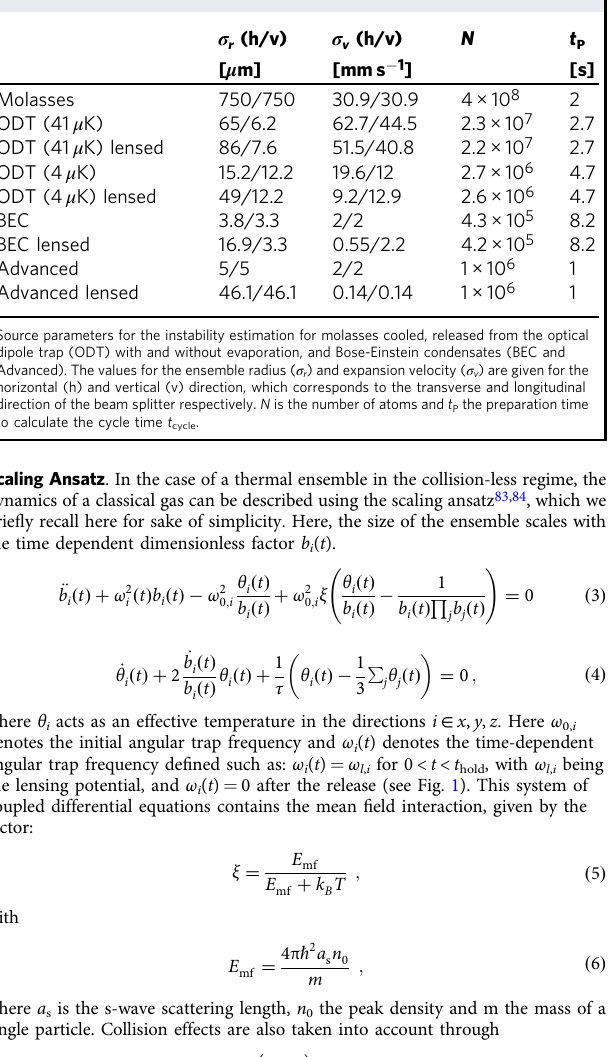
Table 1 Source parameters for the instability